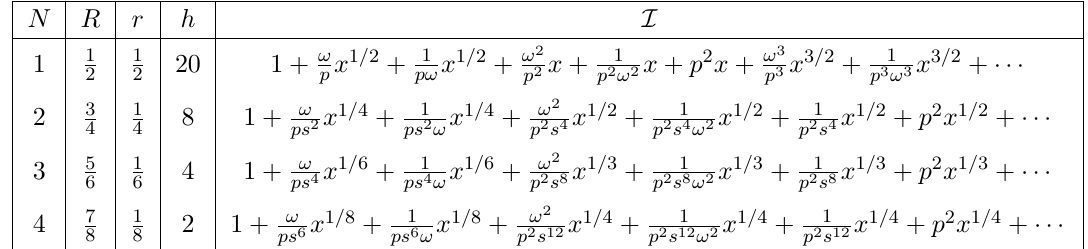
(cid:0) (cid:1) x h .